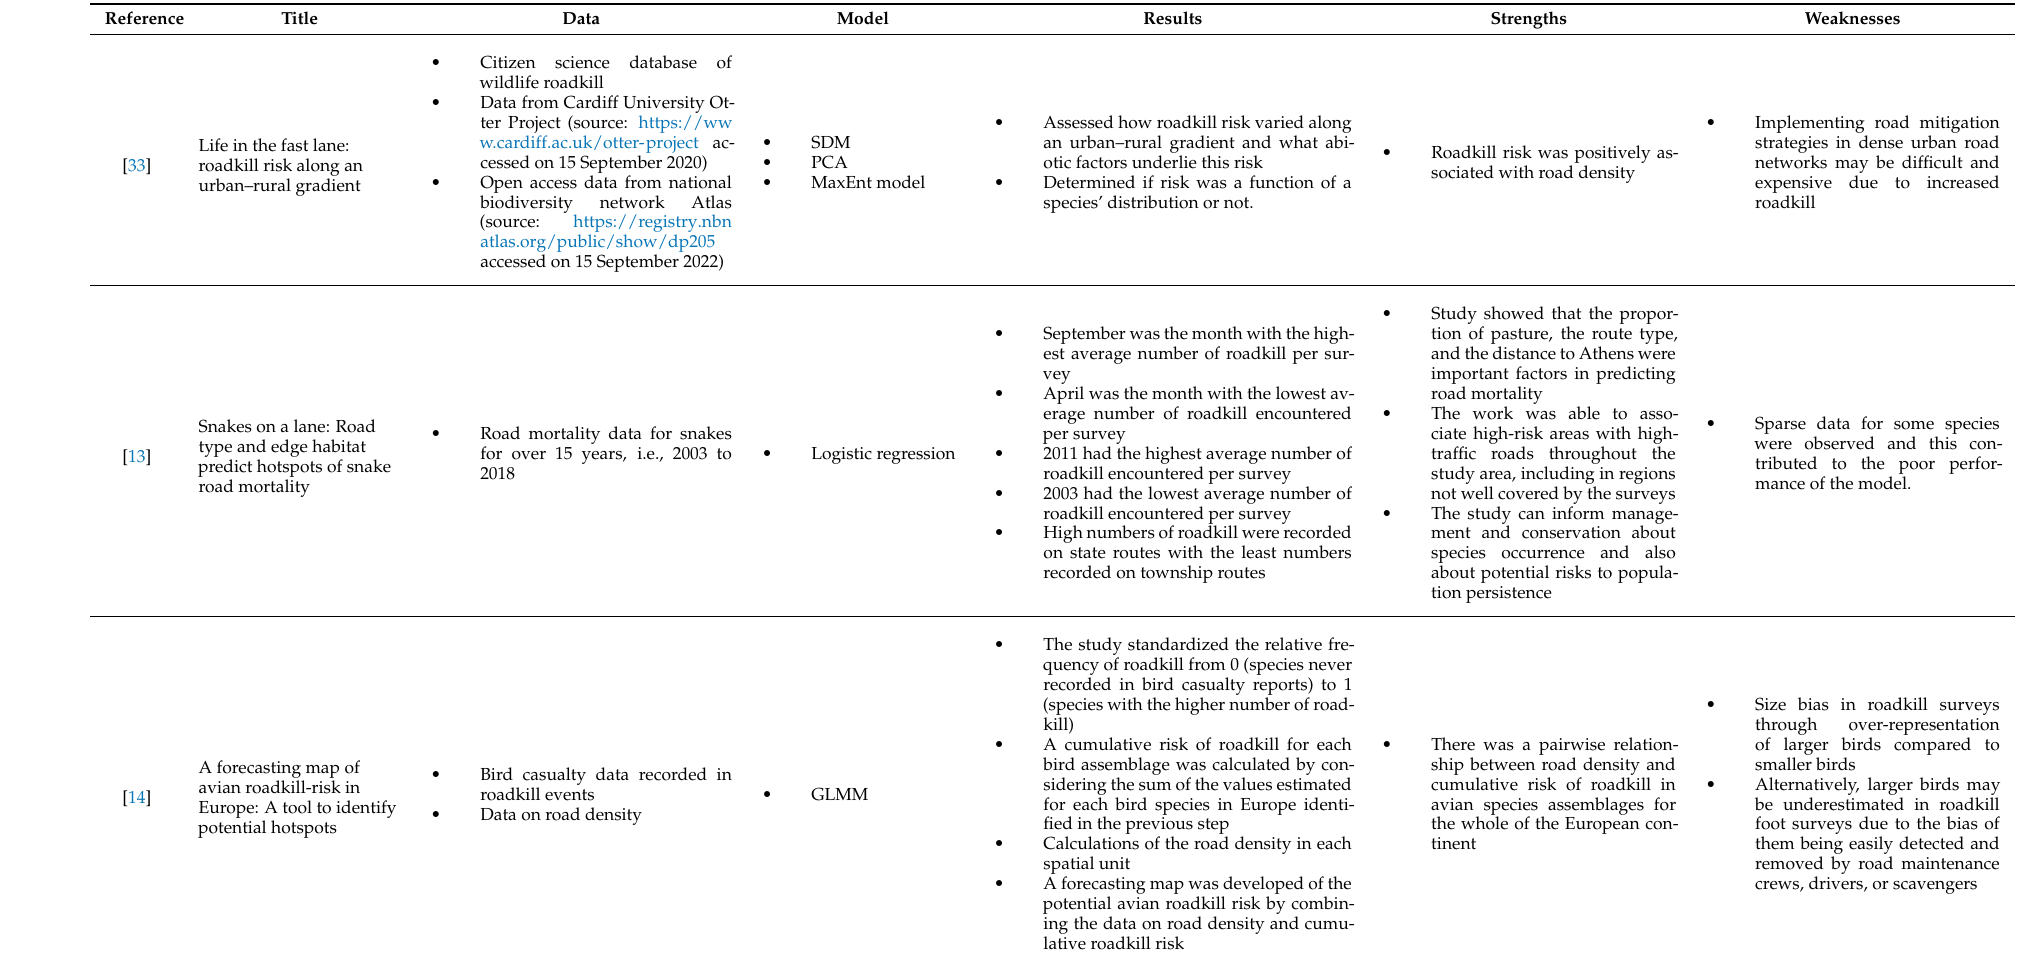
Table A1. Traditional methods used to forecast wildlife roadkill patterns in terms of their performances, strengths, and